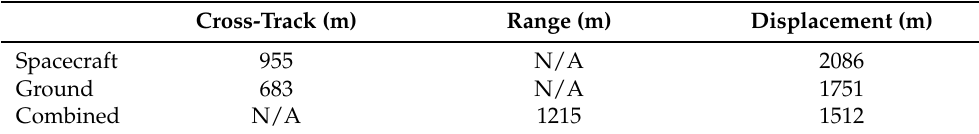
Figure 8. Observer’s reference frame and definition of key astrometric parameters. Table 3. Error in RSO position estimates for RCM